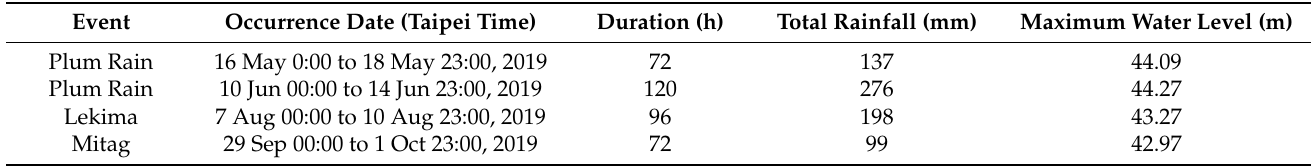
Table 1. Selected typhoons and rainy events were used in the